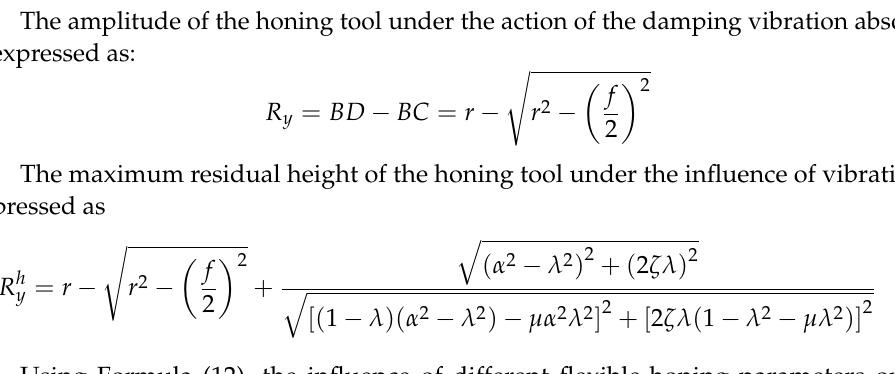
Figure 6. Honing residual height of face-gear tooth surface.